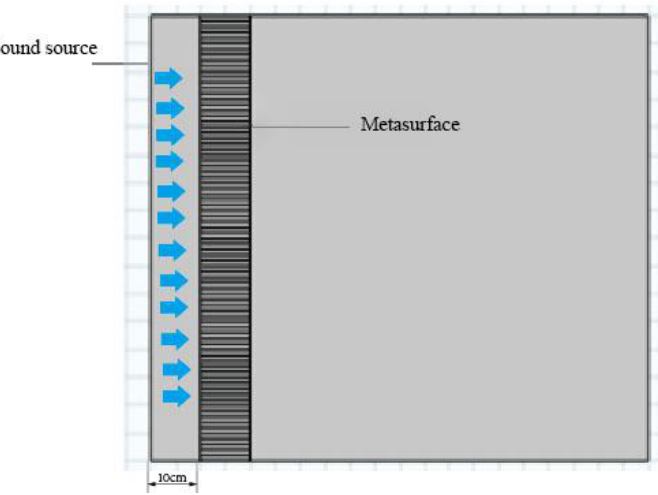
Figure 4. Distribution of the metasurface on the y -axis.